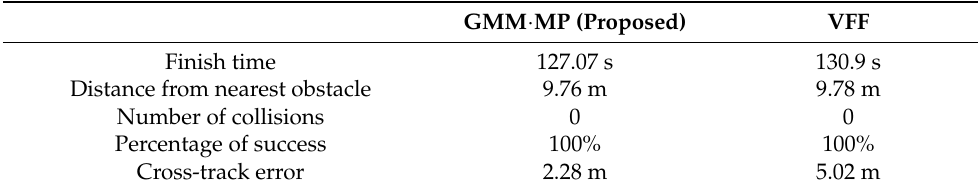
Figure 14. Comparison of GMM · MP and VFF trajectories for fixed obstacles. Table 2. Evaluation of obstacle avoidance performance for different collision avoidance methods in the scenario with multiple fixed obstacles.